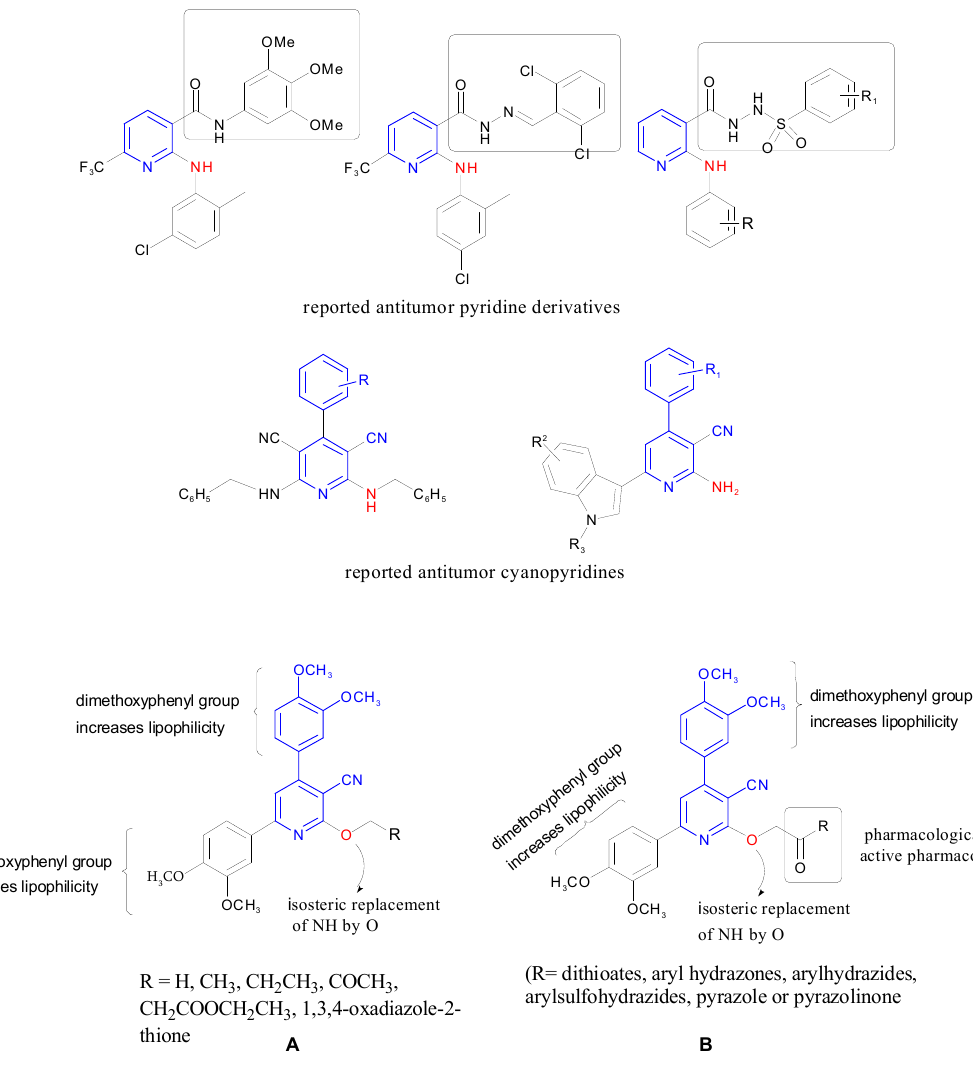
Figure 1. Chemical structure of reported pyridines and cyanopyridines endowed with anticancer and apoptosis-inducing activities and the synthesized compounds ( A , B ).